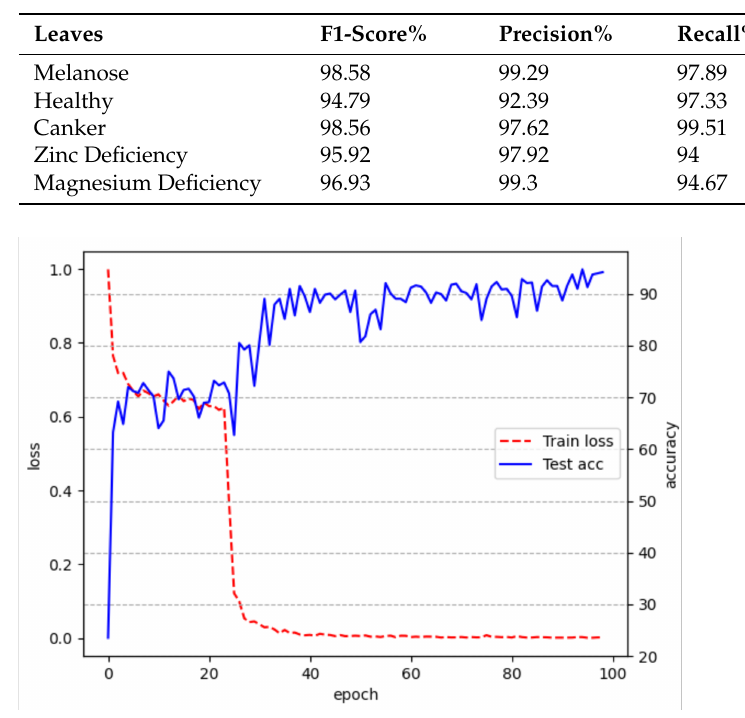
Figure 12. Training loss and test accuracy of the EfficientNet-B5-pro